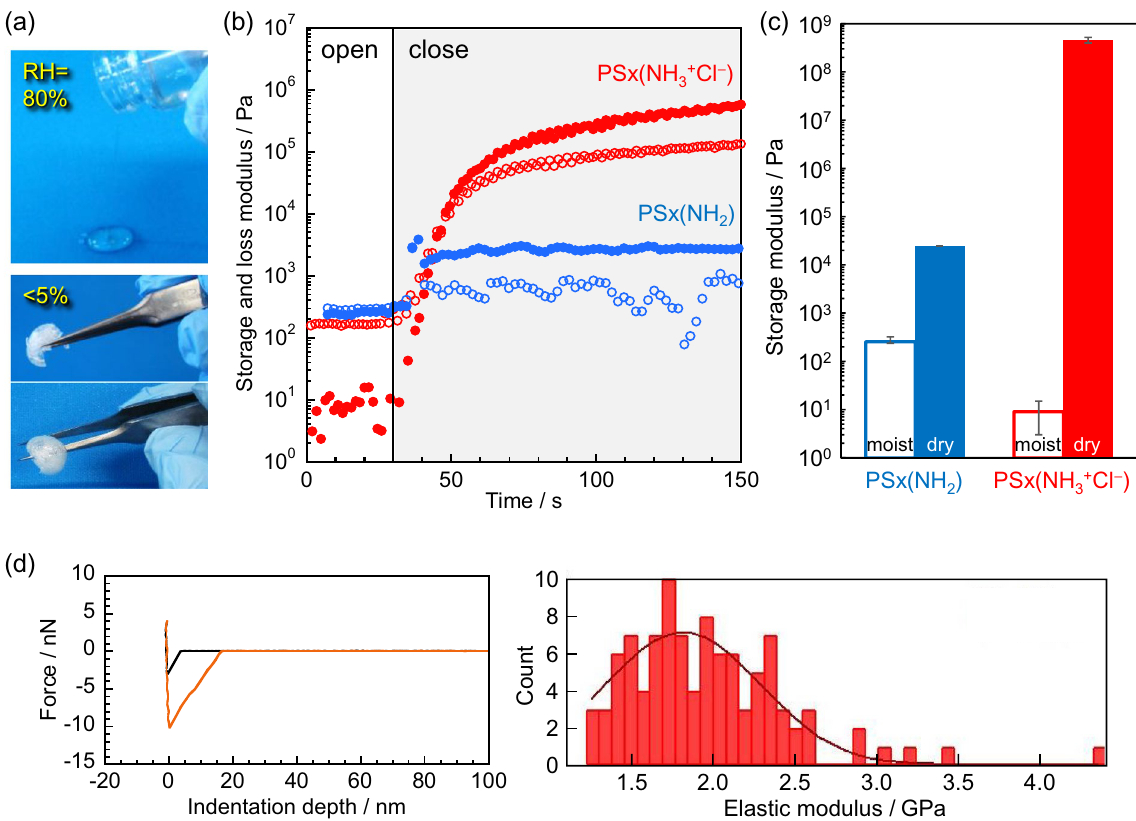
Figure 2. ( a ) Snapshots of the appearance of moist- and dry-PSx(NH 3 + Cl − ). ( b ) Storage and loss moduli changes of PSx(NH 2 ) (blue) and PSx(NH 3 + Cl − ) (red) during the drying process. ( c ) Storage modulus of the moist- or dry-state of the polysiloxanes. ( d ) Force curve of dry-PSx(NH 3 + Cl − ) at one point (left) and its Young’s modulus histogram at 100 points (right). Black and orange lines in the left figure show the approach and retraction processes to the film,